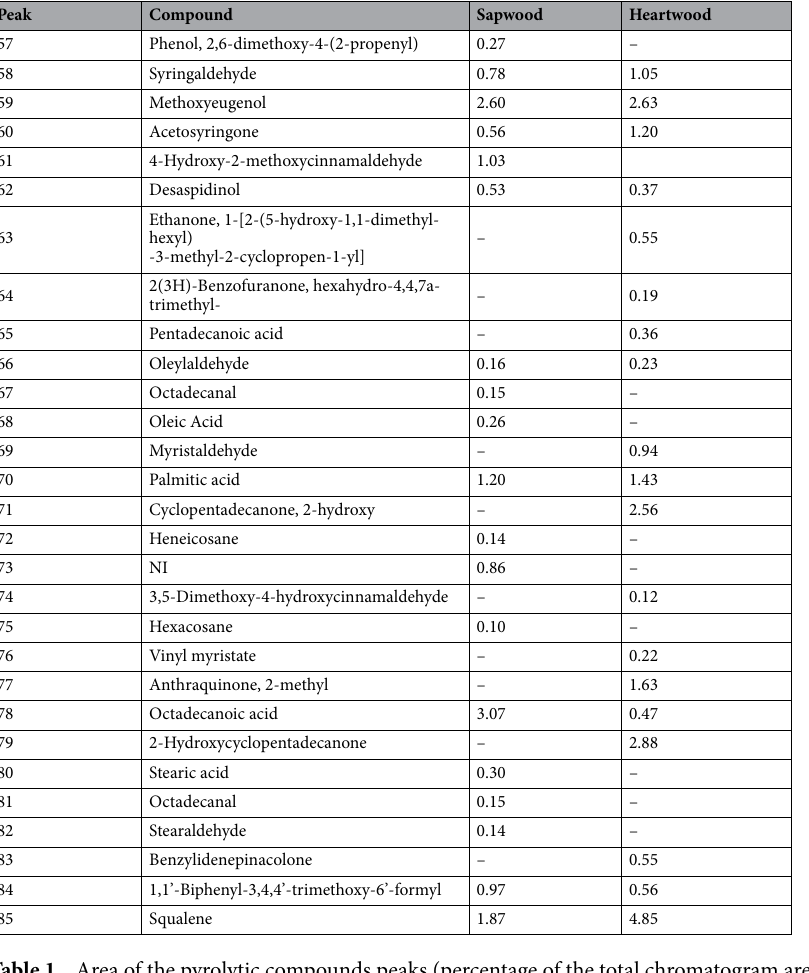
rearrangements in the carbohydrates resulting in isomers lacking molecular ions and, therefore, difficult to interpret 21 . Levoglucosan was the main pyrolytic product formed from the heartwood sample (26.65%). The formation of levoglucosan is due to the conversion of cellulose, hemicellulose, lignin and extractives from biomass into sugar, acids and furans, compounds with larger areas 7 . Sugars can be used as a carbon source, in fermentation, to produce compounds of industrial interest, such as citric acid, ethanol, 5-hydroxymethylfurfural, furans, aromatic hydrocarbons and lipids 22,23 . The biphenyl compounds (1,1’-biphenyl-3,4,4’-trimethoxy-6’-formyl) and anthraquinone, 2-methyl, from the naphthoatraquinone group were identified at the end of the chromatogram of the sapwood and heartwood (Fig. 1). The identification of biphenyl (1,1’-biphenyl-3,4,4’-trimethoxy-6’-formyl) and anthraquinone, 2-methyl com- pounds from the naphthoatraquinone group, at the end of the chromatogram for the sapwood and heartwood are due to the difficulty of fragmentation into small components and because they are derivatives of lignin. This compound, during pyrolysis, releases a mixture of phenolic derivatives preserving the aromatic ring, with the original methoxyl groups, and a part, or all, of the side chain of propane 20 . These components, with antifungal and bactericidal properties, protect the plant against xylophagous organisms, increasing the durability of its wood 24,25 . In addition, anthraquinones can replace synthetic dyes 26–28 . Syringyl/guaiacyl ratio. The syringyl/guaiacyl (S/G) ratio was 0.51 ± 0.010 and 0.50 ± 0.012 for the sap- wood and heartwood respectively. The 4-vinylsyringol, trans-coniferyl alcohol and coniferaldehyde, 4-vinyl- guaiacol, 4-methylguaiacol, vanillin and sinapinaldehyde were the main compounds derived from lignin. The S/G ratio of the T. grandis heartwood and sapwood was lower than that of the 70-year-old teak wood from the DBH position, 0.8 for heartwood and sapwood with total lignin content of 35.4% for the sapwood and 37.3% for the heartwood 15 and for the 12 years old teak trees with a total lignin content of 31% and a S/G ratio of 0.72 29